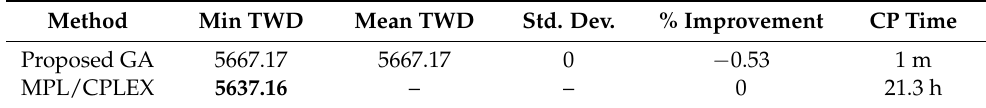
Table 4. Summary of results for test problem